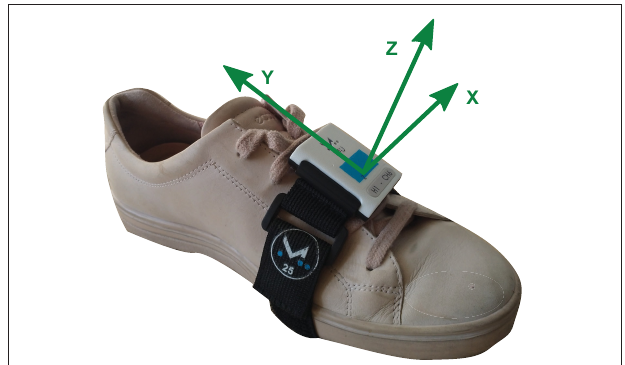
FIGURE 1 | Inertial sensor position and orientation.